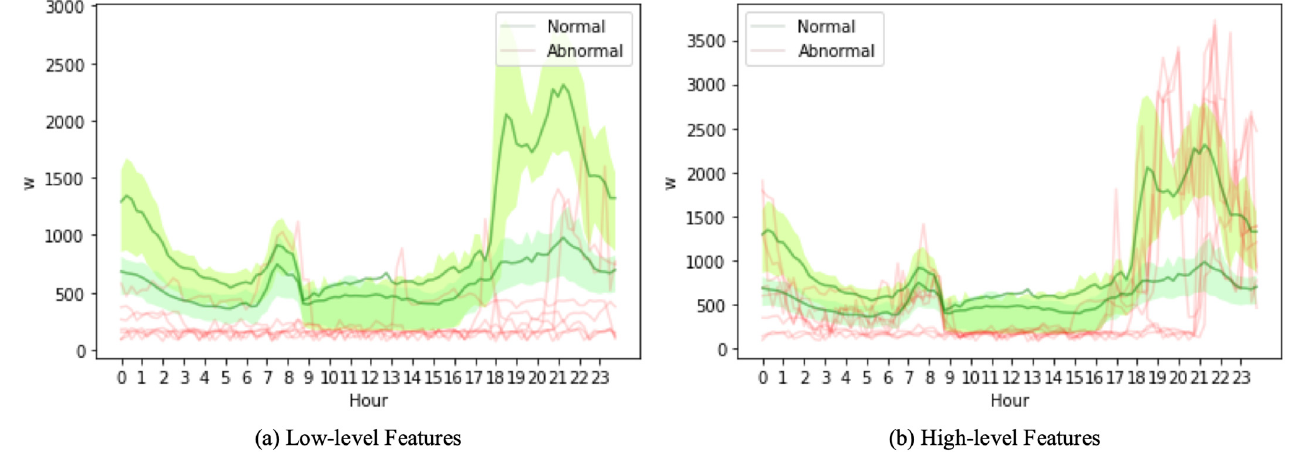
Figure 8. Load profiles of the main and abnormal electricity consumption events of User 04.